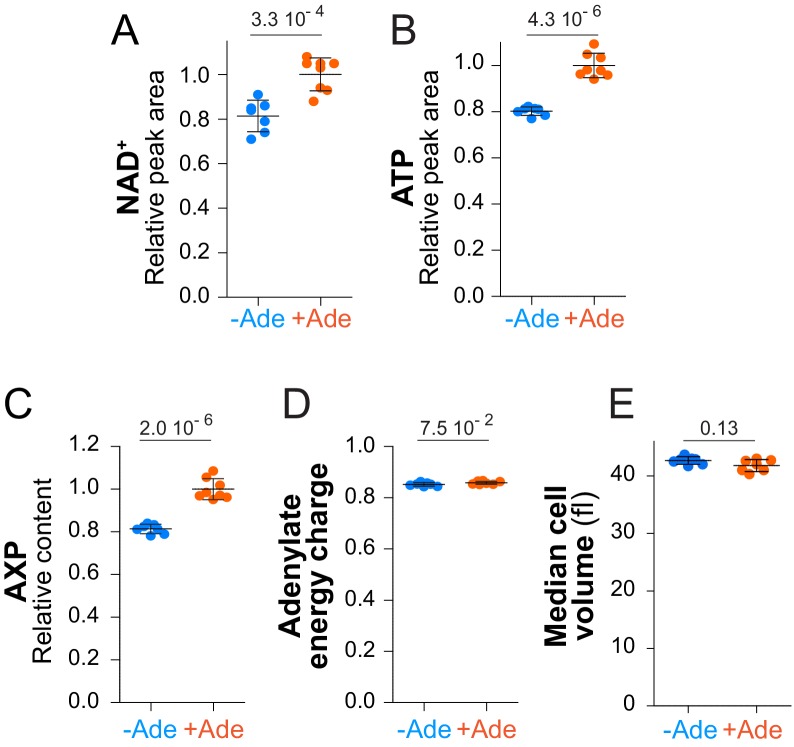
NAD+, ATP, AXP, adenylate energy charge and median cell volume variations in response to adenine availability under respiratory conditions.(A–D) The prototrophic wild-type strain (FY4) was exponentially grown for 24 hr in SGEcasaWU supplemented (orange dots) or not (blue dots) with adenine. Metabolite extraction, separation and quantification were done as in Figure 2. Quantifications were determined from independent metabolite extractions (N ≥ 7) and standard deviation is presented. The amount of each metabolite measured in cells grown in the presence of adenine (orange dots) was set at 1. Indicated p-values were calculated using a Welch’s t-test. AXP and adenylate energy charge were determined as described in the Materials and methods section. (E) Median cell volume was determined with a Multisizer IV (Beckman coulter) on the independent cell cultures used for the metabolic extraction presented in this figure (N ≥ 7).10.7554/eLife.43808.023Figure 3—figure supplement 4—source data 1.Metabolic analyses for the FY4 prototrophic strain grown in glycerol/ethanol medium ±adenine.10.7554/eLife.43808.024Figure 3—figure supplement 4—source data 2.Median cell volume for the FY4 prototrophic strain grown in glycerol/ethanol medium ±adenine.